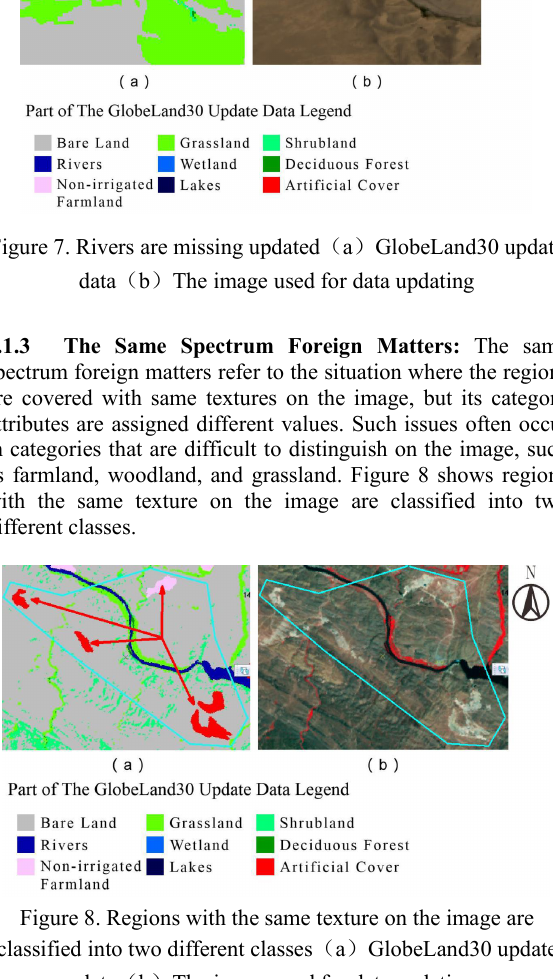
Figure 3. Open pit is misclassified as wetlands and lakes （ a ） GlobeLand30 update data （ b ） The image used for data